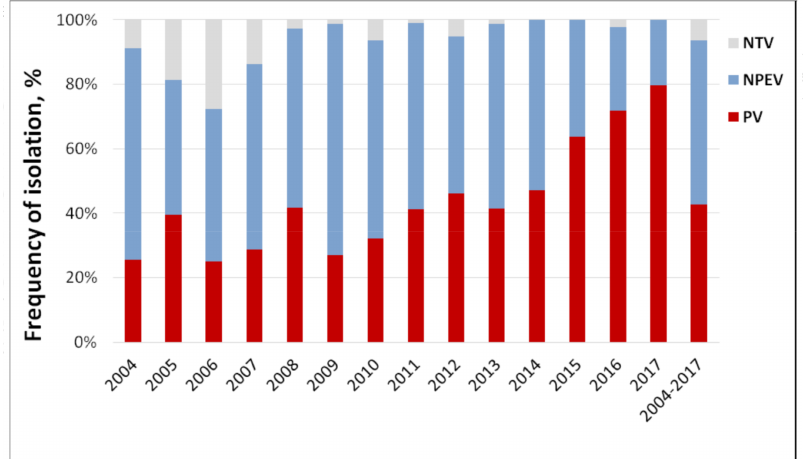
Figure 3. Annual ratio of polio and non-polio enteroviruses in sewage samples, Moscow, 2004–2017. NTV—non-typed virus, NPEV—non-polio enterovirus, PV—poliovirus.